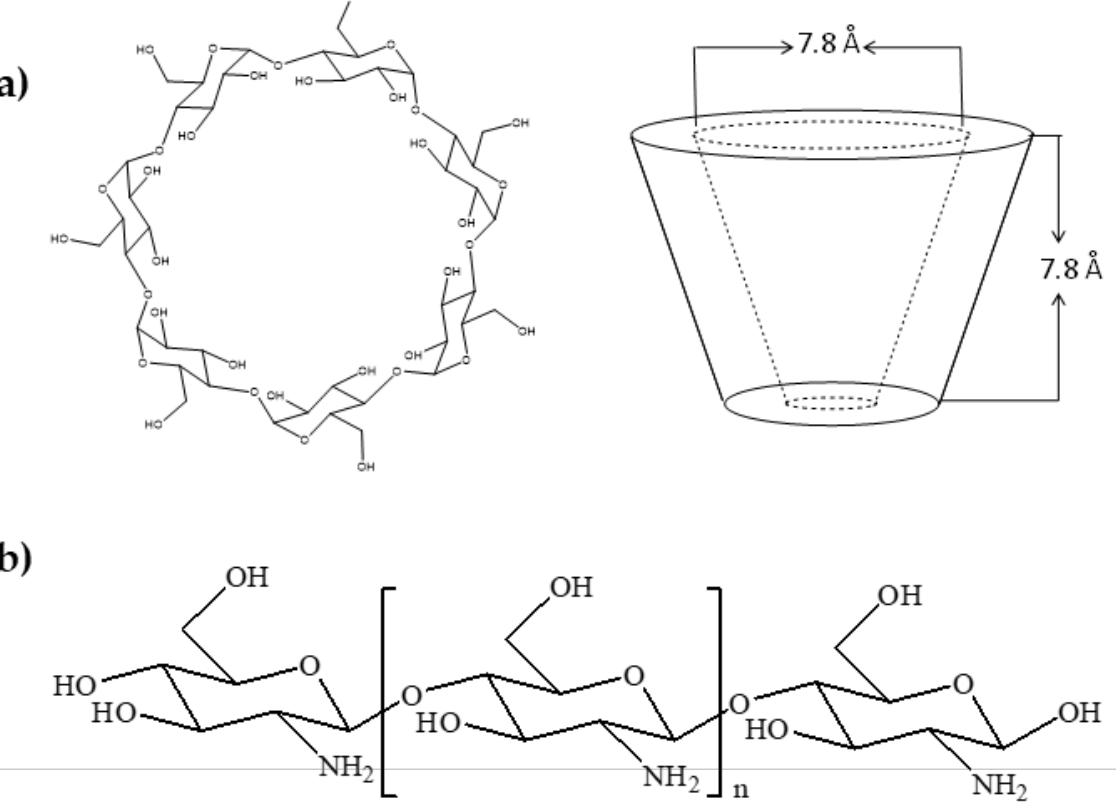
Scheme 1. Molecular structure of polysaccharide precursors: ( a ) β -cyclodextrin ( β -CD) and ( b ) chitosan (CS).